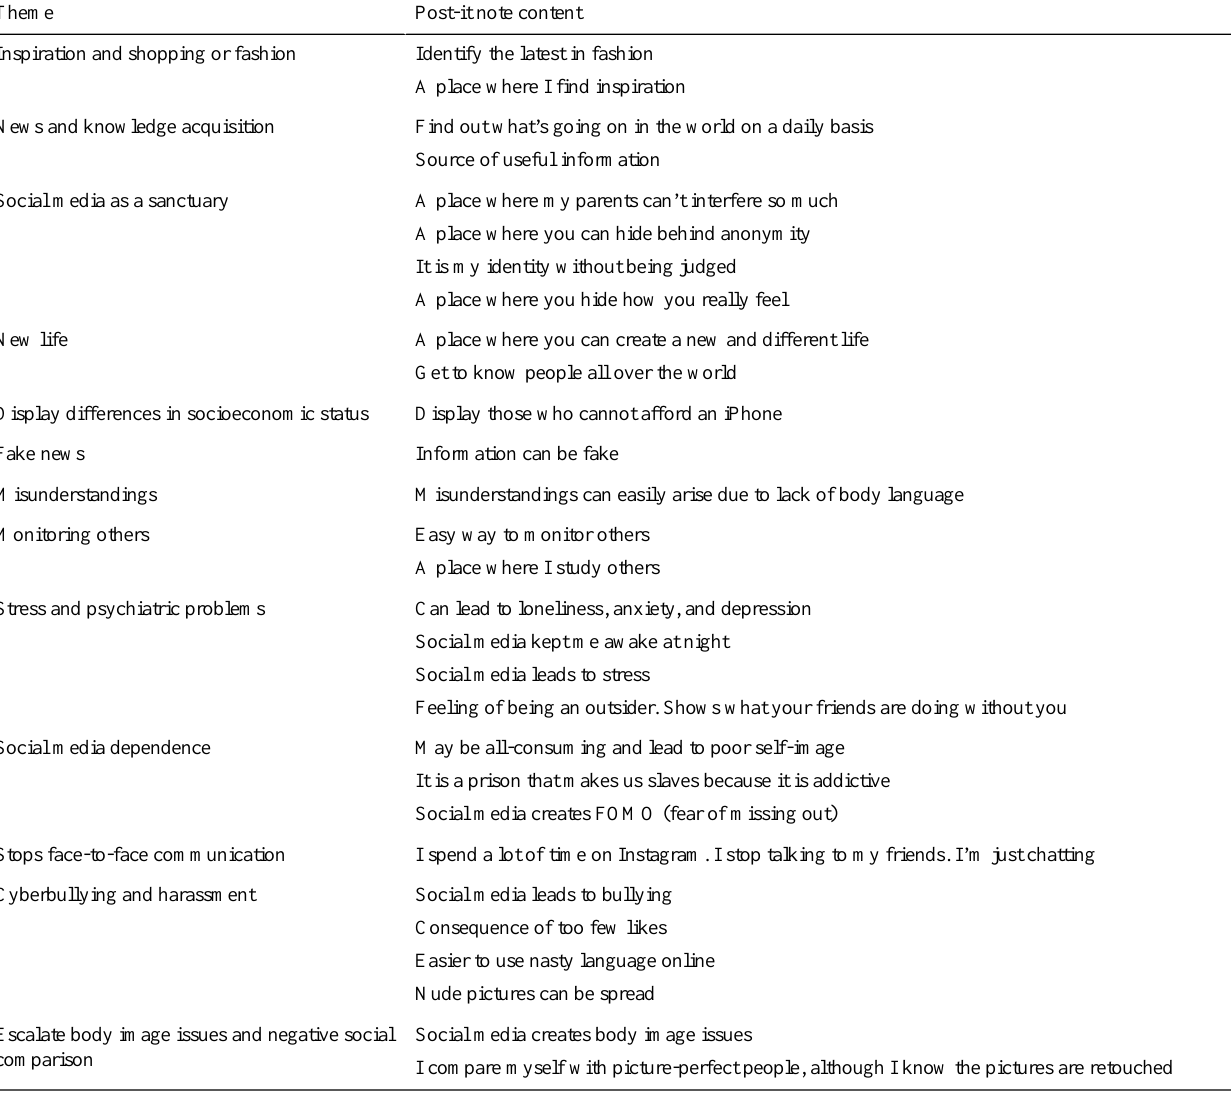
Table 2. Field correspondence: themes included on Post-it notes, but not included in full-class or focus group